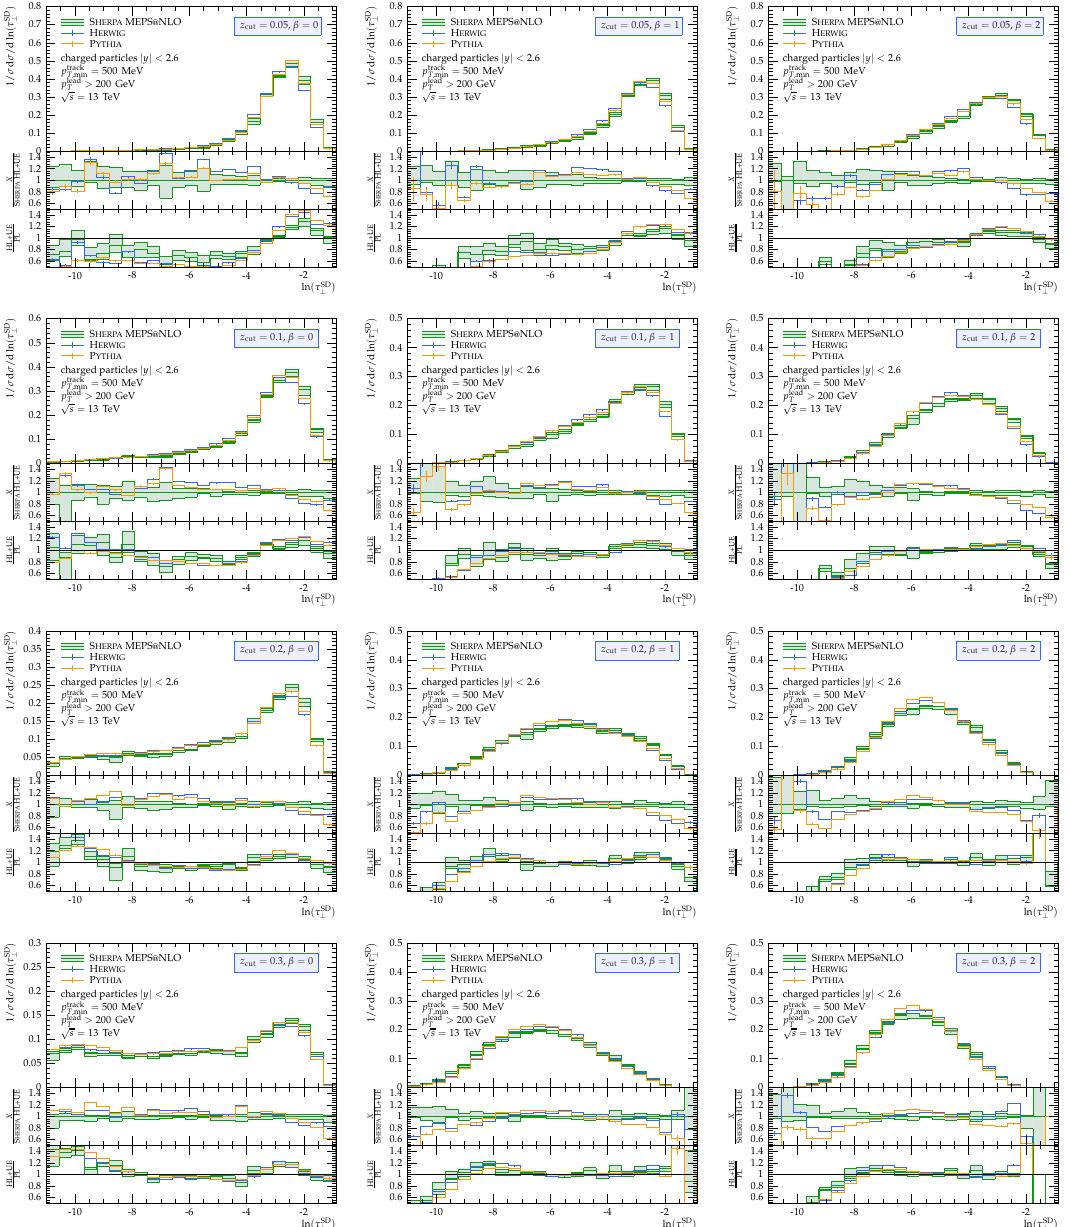
Figure 15 . Hadron-level results based on charged-particle tracks with p track groomed thrust with β ∈ { 0 , 1 , 2 } (columns) and z cut ∈ { 0 . 05 , 0 . 1 , 0 . 2 , 0 . 3 } (rows) for the p T, min = 200 GeV event selection. Shown are predictions based on the leading-order dijet production from P YTHIA and H ERWIG , as well as the MEPS @ NLO result from S HERPA . The two lower panels present the ratios with respect to the S HERPA hadron-level prediction and the generators’ parton- level prediction,